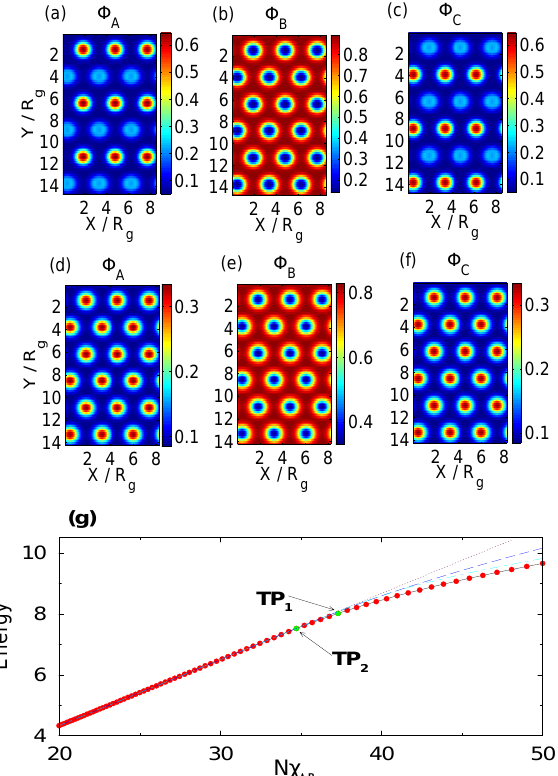
Figure 2. (a), (b) and (c) show spatial monomer densities of the A, B, and C components of the polymer, respectively, after the secondary transition (see text for details) for χ N = AB χ N = 37 . 3 and χ N = 28 . 3 . (d), (e) and (f) show spatial monomer densities in between BC AC the primary and secondary transition for χ N = χ N = 34 . 7 and χ N = 26 . 3 . (g) AB BC AC shows the free energy of the melt as a function of the Flory-Huggins parameter χ N = AB χ N = 3 χ N . The two transition points ( T P ) and ( T P ) are also shown. Also shown BC AC 1 2 4 are the free energies of the disordered phase (short-dashed line), the lamellar phase (short- dashed/long-dashed line) and the hexagonal phase in which A and C components mix (long- dashed line).